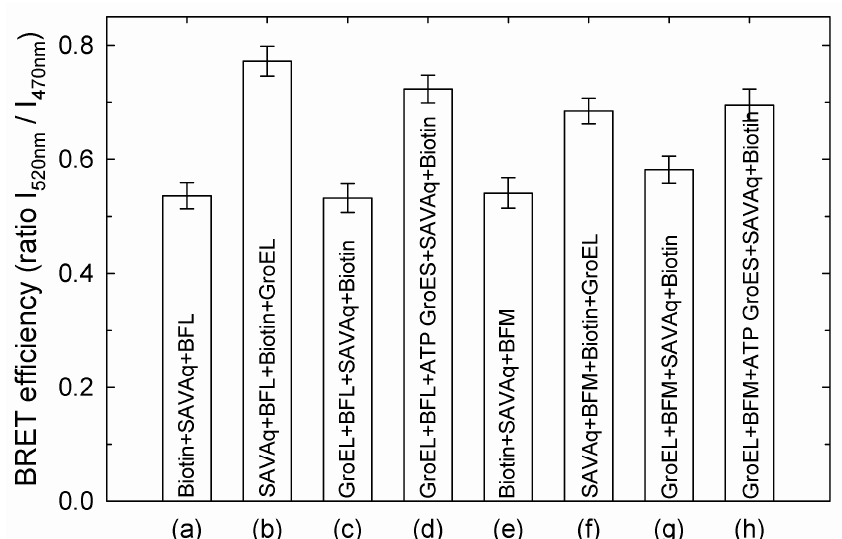
Figure 4. The intensity ratio I 520 nm / I 470 nm for streptavidin-aequorin bioluminescence spectra recorded after manipulations described in Legend to Figure 3. The fluorescein- and biotin-labeled α -lactalbumin (BFL) is lettered as (a), (b), (c), (d), while malate dehydrogenase (BFM) as (e), (f), (g), (h). The arrows (I) show mean-square errors derived from averaging of 10 spectra.